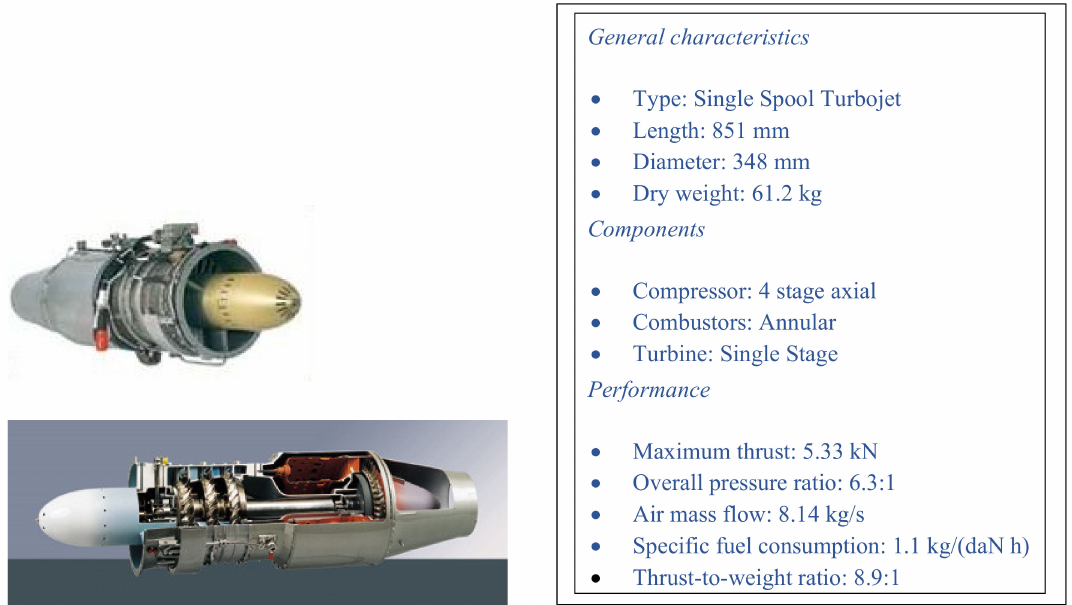
Figure 14. The schematic and characteristics of the modelled turbojet engine (images from